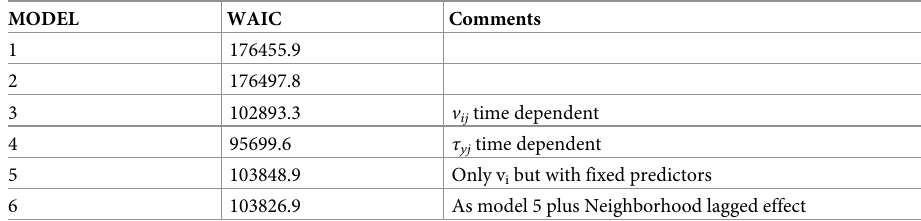
Table 4. 3D data results: South